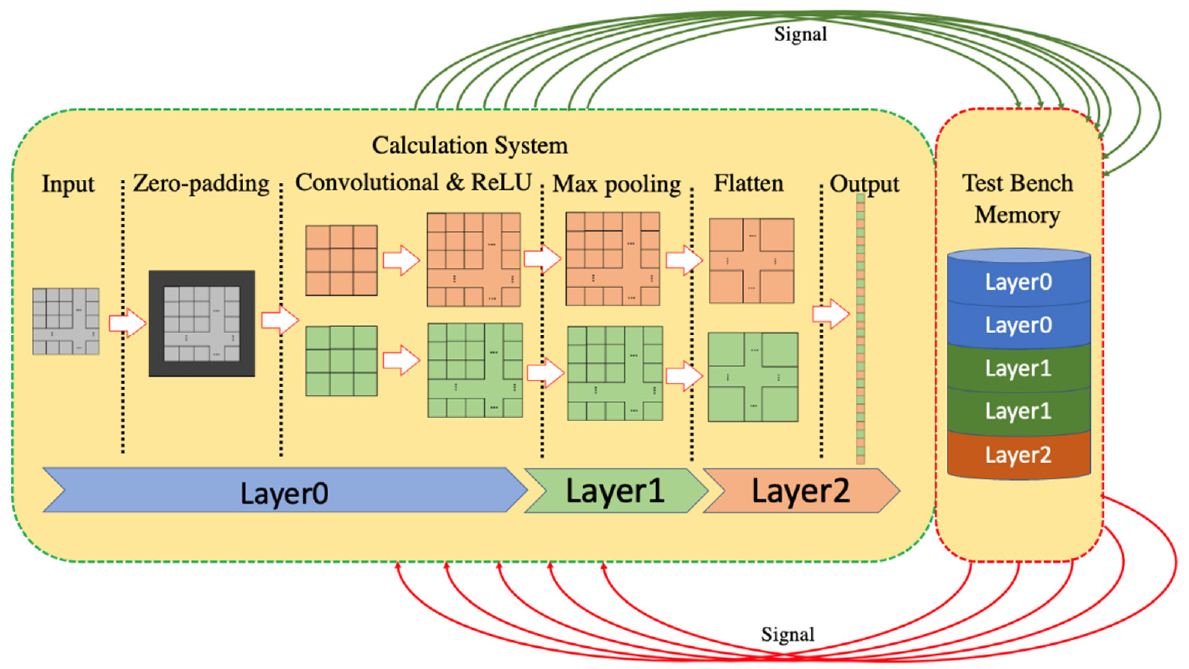
Figure 2. Image convolution test bench with 20 signal circuits and 5 memories with CNN architecture diagram with 3 layers, and the architecture of the proposed stride 1 CNN for classification. The kernel of the architecture was set to 3 × 3, the input set to 64 × 64, and the output set to 4096 ×